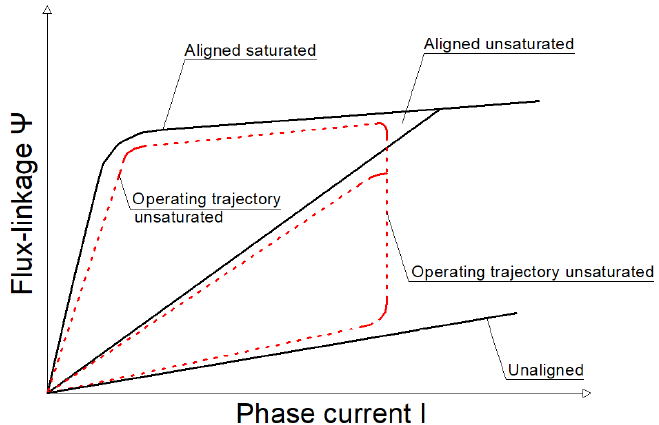
Figure 3. Characteristics diagrams ψ -i showing the energy conversion for an SRM engine employing material saturation and not employing it [19].